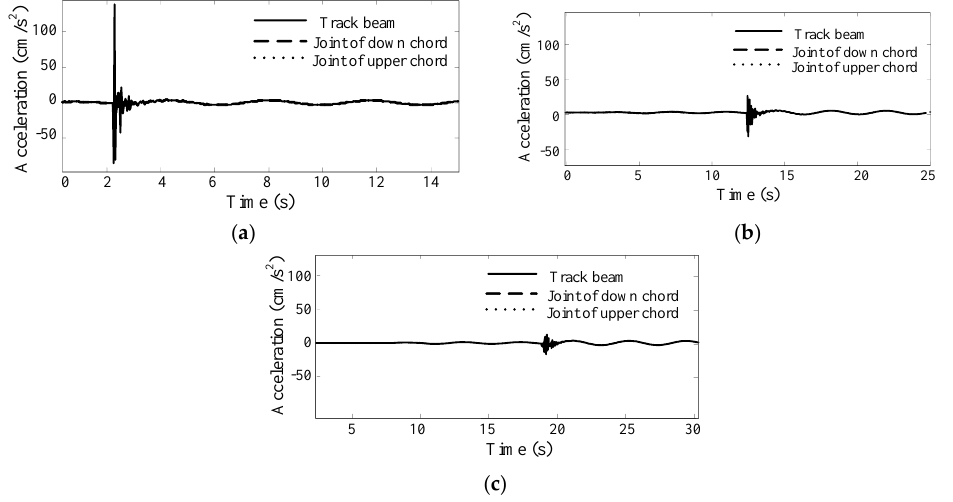
Figure 14. The longitudinal acceleration with the train braking in the middle of the bridge at a speed of 40 km/h: ( a ) the middle of the main span; ( b ) the quarter position of the main span; ( c ) the middle of the Y-shaped rigid frame.